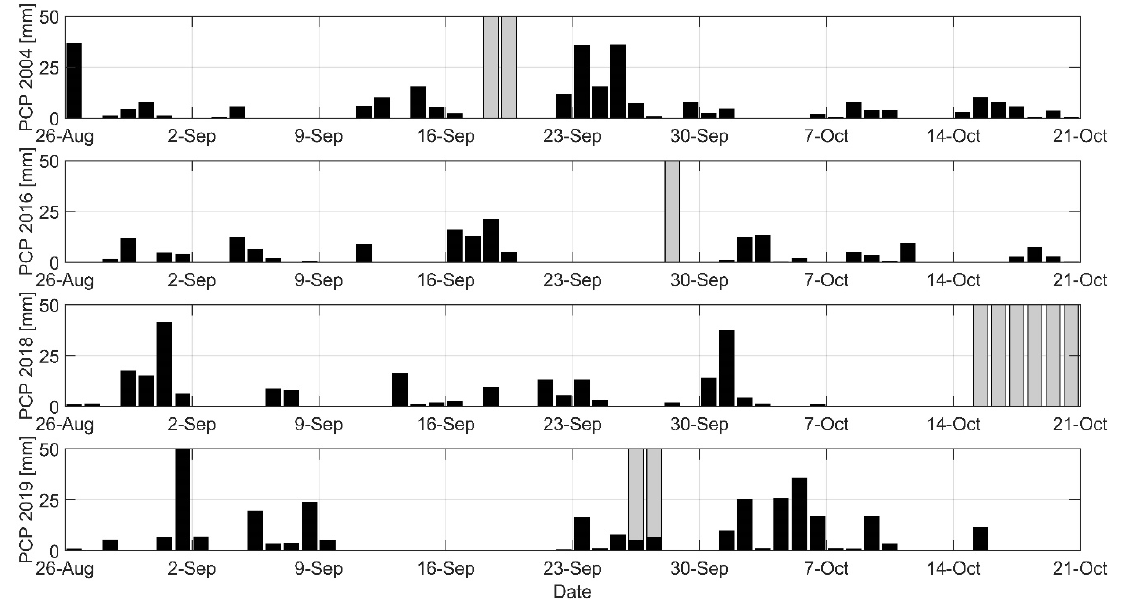
Figure 7. Daily precipitation heights PCP [mm] at the DWD station Zugspitze (black) and days of absolute measurements (grey) in the years 2004, 2016, 2018 and 2019.